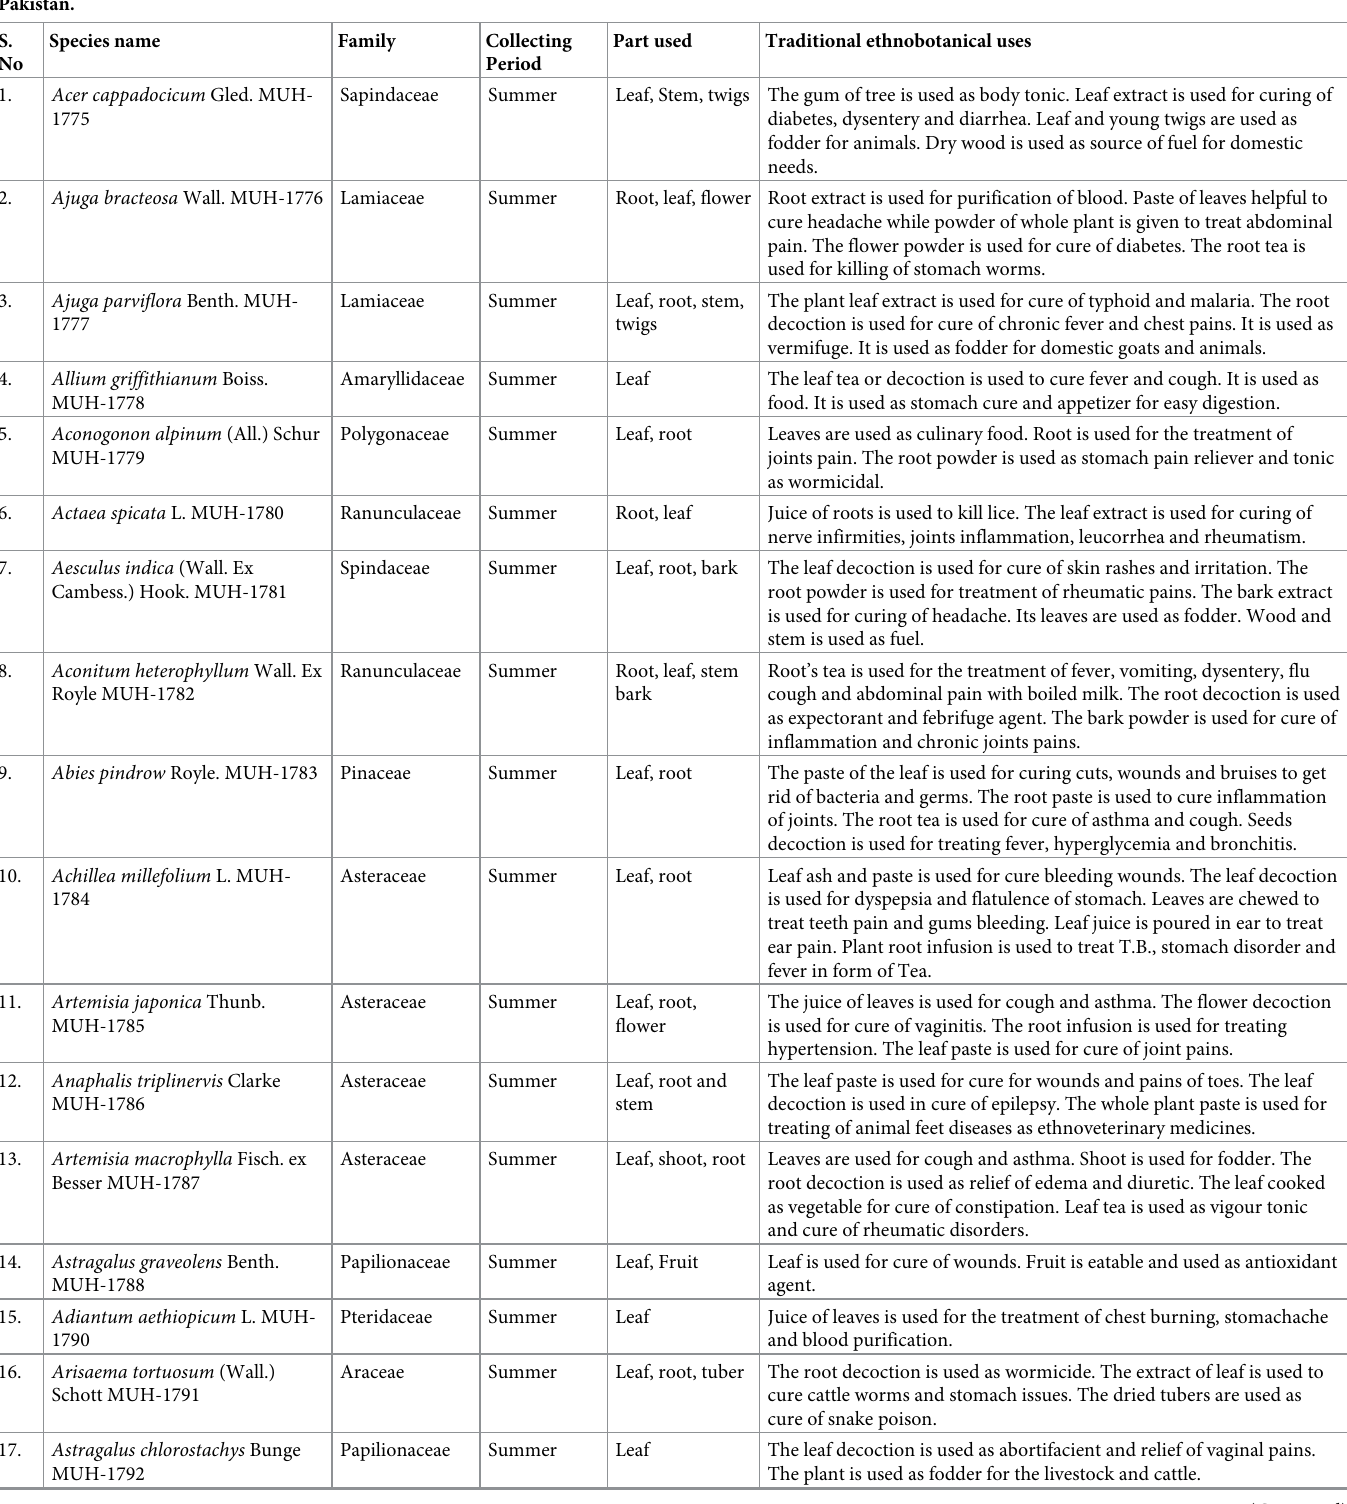
Table 4. Traditional ethnobotanical uses of wild indigenous plant species recorded from Dawarian and Ratti Gali, District Neelam Azad Jammu and Kashmir, Pakistan. S.